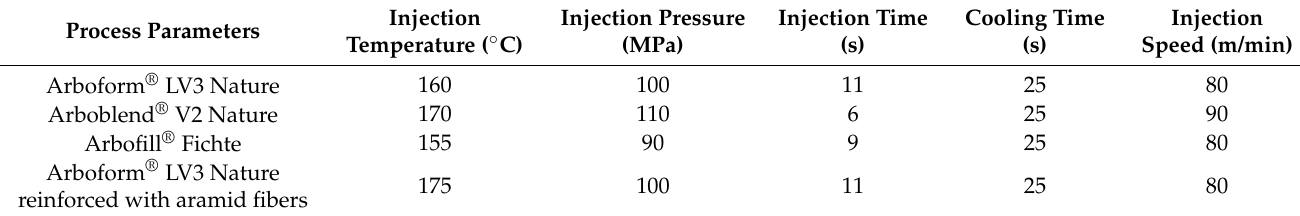
Table 2. Main technological parameters used at injection